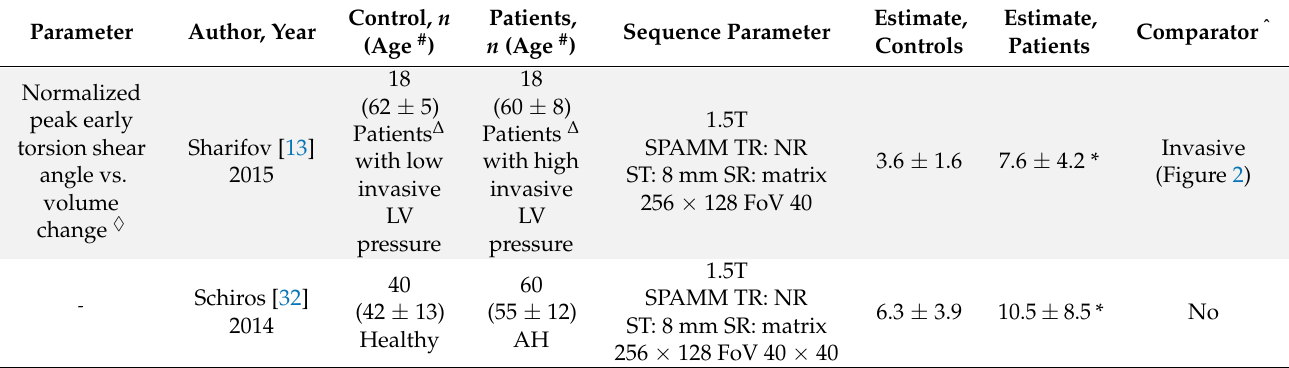
Table 4. CMR tagging—peak change of the torsion shear angle versus volume curve in the early diastole ( − d ϕ (cid:48) /dV (cid:48) ).